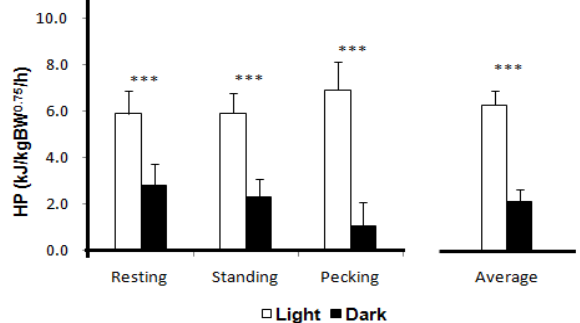
Figure 1. Energy expenditure of broiler chickens exposed to light and dark conditions for 2 h. Asterisks indicate the statistically significant difference (p<0.001). HP, heat production; BW, body